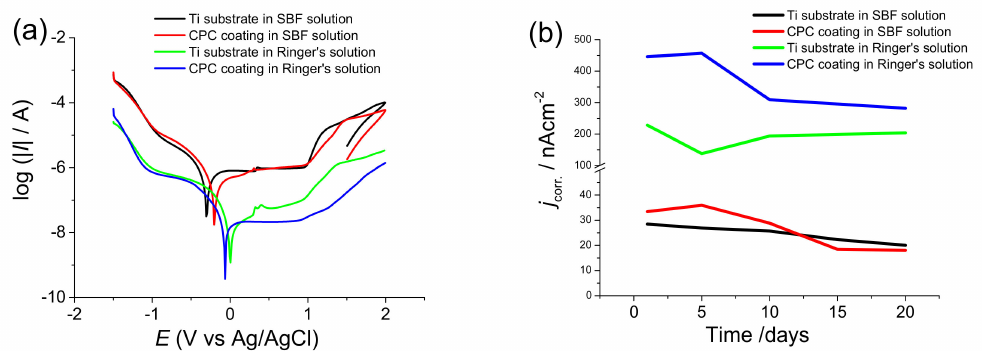
Figure 7. Potentiodynamic polarization curves after two weeks of immersion ( a ) and the measured corrosion current densities over time ( b ) of the CPC coating (S5) and substrate material in di ff erent physiological solutions.